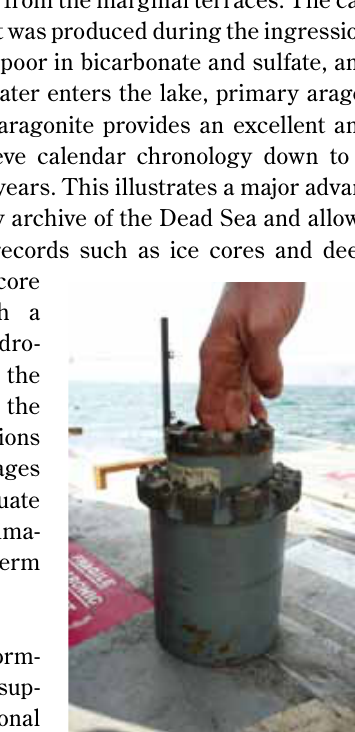
Fig. 1: The National Aeronautics and Space Administration, Fig. 2: Michael Lazar, Department of Marine Geosciences, Fig. 3: Uli Harms, ICDP, GFZ Potsdam, Germany